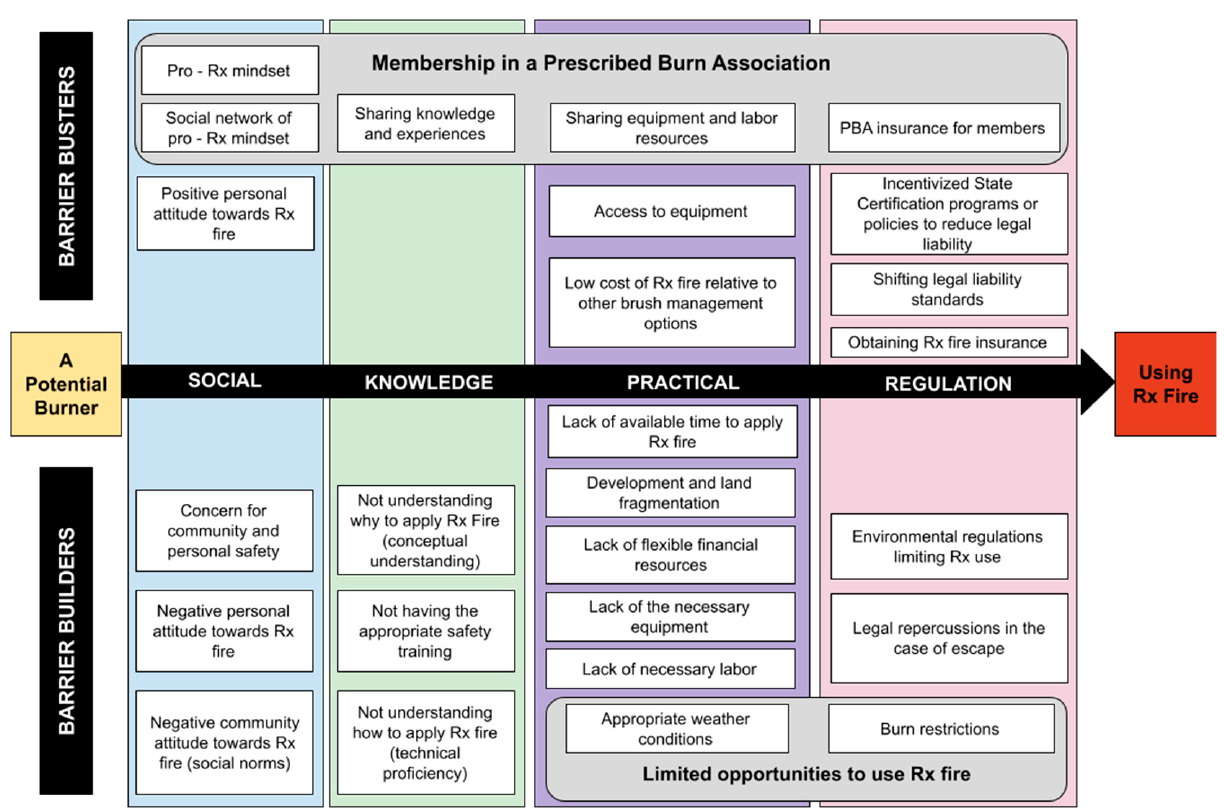
Figure 3. Conceptual model of the barrier builders and barrier busters currently reported by the studies included in this review that affect whether a potential prescribed fire practitioner in the US Great Plains might actually use prescribed fire. Barrier builders are circumstances that limit or prohibit the use of prescribed fire. Barrier busters are tools or resources that support or encourage the use of prescribed fire. Barrier builders and busters were organized into four categories as interpreted by the research team. The gray boxes represent barrier busters or builders that span more than one category with specific examples listed therein. Citations for these statements can be found in Appendix A.